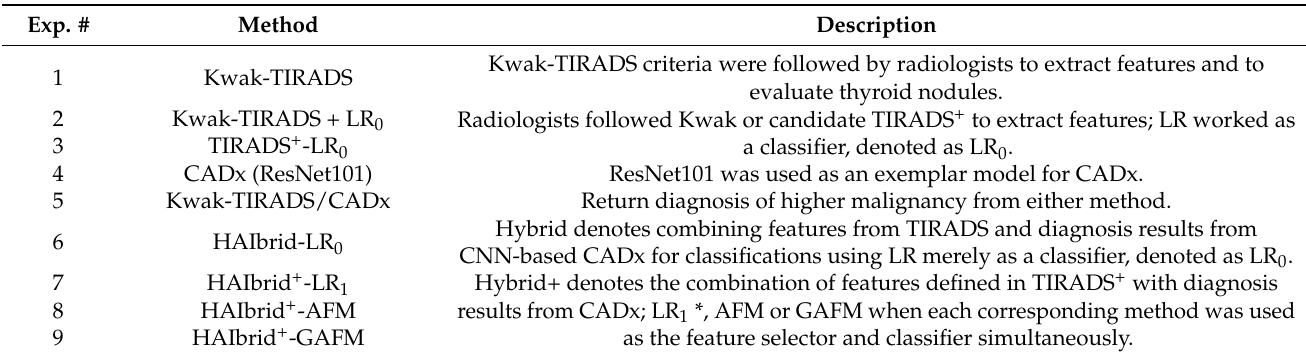
Table 1. Experiment ID, the corresponding method and short